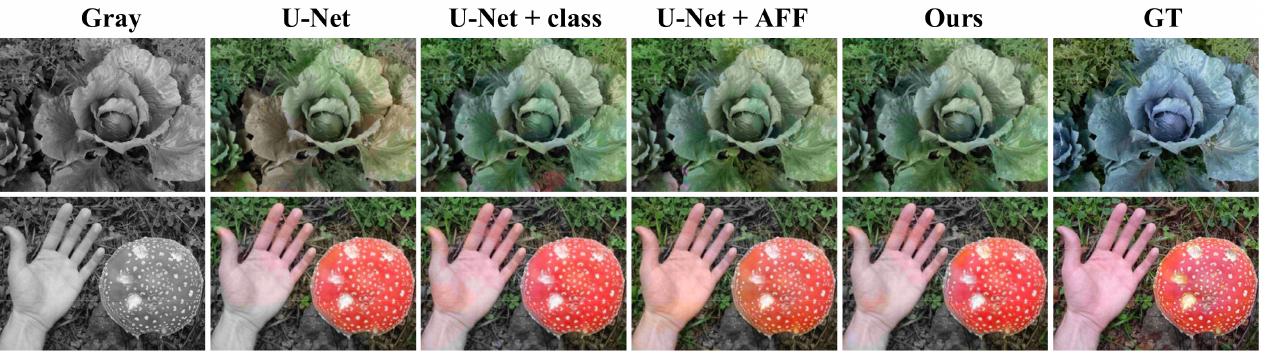
Figure 7. Ablation experiments. The classification subnetwork can help the colorization network to color more accurately. The AFF module can improve the color overflow phenomenon and can enhance the colorization